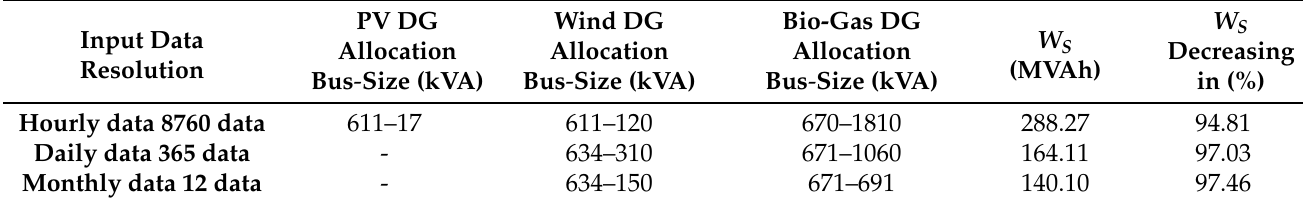
Table 12. Impact of the input data resolution (Opt 1 optimization problem with W S